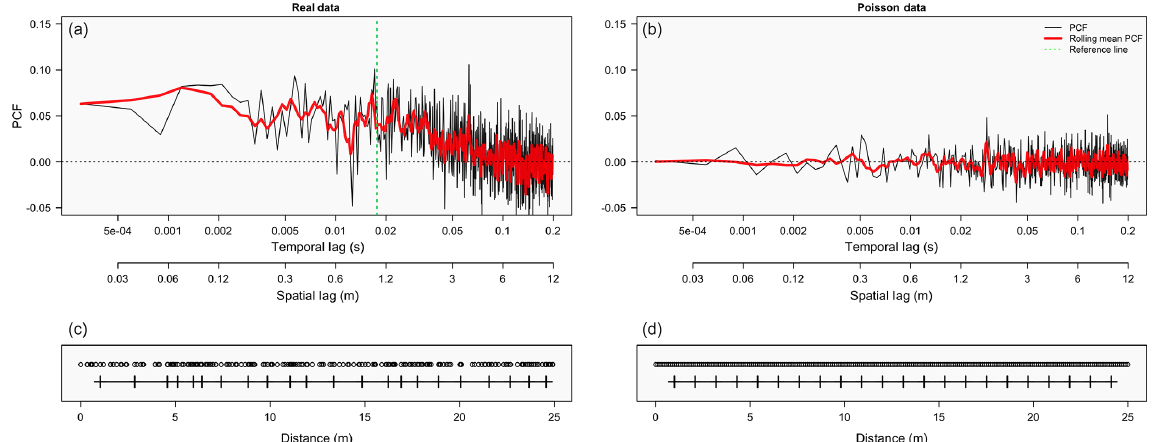
Figure 1. Panels (a) and (b) represent the clustering signature for the PCF, with the x axis showing the temporal and spatial lag on a log scale and the y axis representing the PCF (unitless). Panel (a) shows the PCF for data from a randomly selected portion of cloud covering a temporal range of 2 seconds ( ∼ 120m) with a population of 2168 droplets. Panel (b) shows simulated Poisson point data with the same temporal scale and droplet population. The red line represents a rolling mean of five for the raw PCF values (shown in black). Panels (c) and (d) represent short 25m subsets ( ∼ 270 droplets) of the data used in generating the PCF curves. Each circle represents a cloud droplet, and each line with vertical bars represents the distance traversed for each sampling volume, with each vertical bar corresponding to a droplet count of 10. The green vertical line is used for reference, where the mean value of the PCF is obtained by taking PCF values to the left of the green